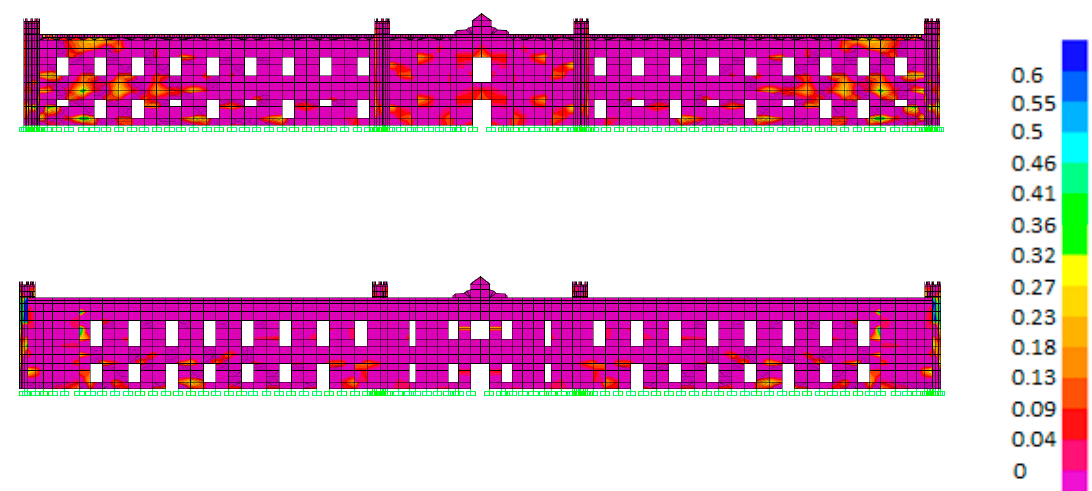
Figure 17. Elements with reduced elastic modulus.